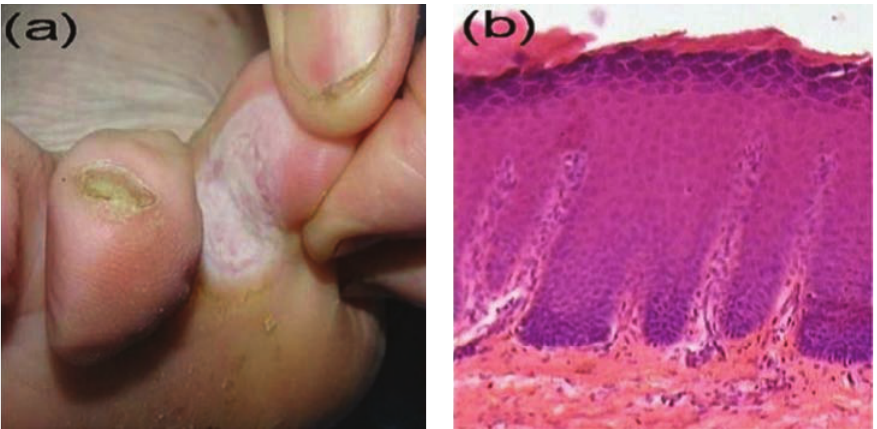
Figure 1: Interdigital eczema. (a) Interdigital whitish plaque with an ill-defined border. (b) Histopathological features of subacute spongiotic dermatitis (H&E, × 100).